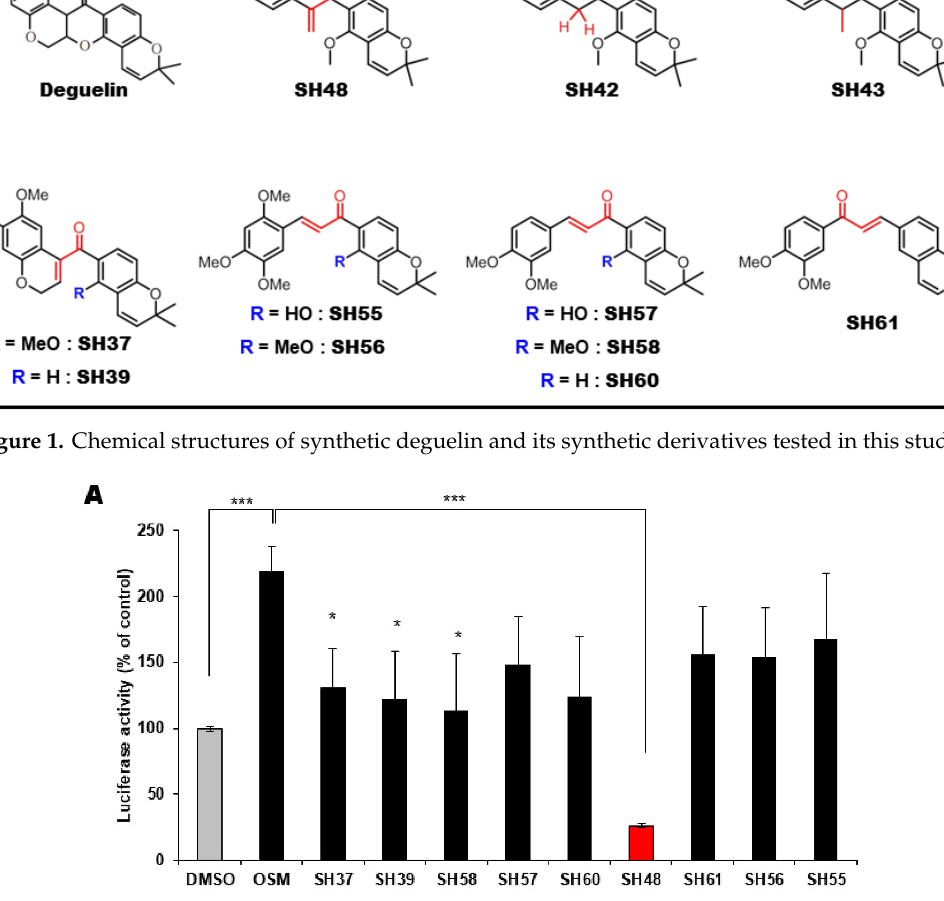
Figure 2. Effects of deguelin analogues on transcriptional activity, nuclear localization and dimerization of signal transducer and activator of transcription 3 (STAT3). ( A ) HeLa/STAT3-luc cells were pretreated with dimethyl sulfoxide (DMSO) or each of analogues (10 μ M) for 24 h, stimulated with 10 ng/mL of oncostatin M (OSM) for another 5 h, and then assayed for the luciferase reporter gene activity as described in Section 2. * p < 0.05; *** p < 0.001. ( B ) Immunocytochemical analysis was performed using p-STAT3 Y705 antibody after the treatment of MCF10A- ras cells with 10 μ M SH48 for 24 h. Cells were stained with PI and visualized by confocal microscopy. Scale bar, 50 μ m. ( C ) Immunocytochemical analysis was performed using HA-tag and Myc-tag antibodies. PC3 cells were treated with 10 μ M SH48 for 24 h. Cells were stained with DAPI and analyzed by confocal microscopy. Scale bar, 50 μ m. 3.2. The α , β -Unsaturated Carbonyl Moiety of SH48 Is Essential for the Inhibition of STAT3 Phosphorylation It is known that the α , β -unsaturated carbonyl group is required for the inhibition of STAT3 phosphorylation by some chalcone derivatives [42]. MCF10A- ras cells were tr eated with a 5 μ M concentration of SH48, SH42, SH43, SSI1204, or SSI1205 for 24 h. SH42 has a substitution in a double bond with hydrogen in comparison with SH48. SH43 has a single bond. As with SH48, SSI1204 has an α , β -unsaturated carbonyl moiety (Figure 3A). SSI1205 has a substitution in the carbonyl group with a hydroxyl group and some addition in a benzene ring (Figure 3A). Then, the protein expression of p-STAT3 as well as STAT3 was measured by Western blot analysis. As shown in Figure 3B, STAT3 phosphorylation was significantly decreased by treatment with SH48 and SSI1204 harboring an electrophilic α , β -unsaturated carbonyl moiety. However, total STAT3 expression was not affected (Figure 3B). In parallel with the inhibition of STAT3 phosphorylation, both SH48 and SSI1204 reduced the viability of MCF10A- ras cells, whereas the other analogues without an electrophilic moiety were not cytotoxic (Figure 3C).